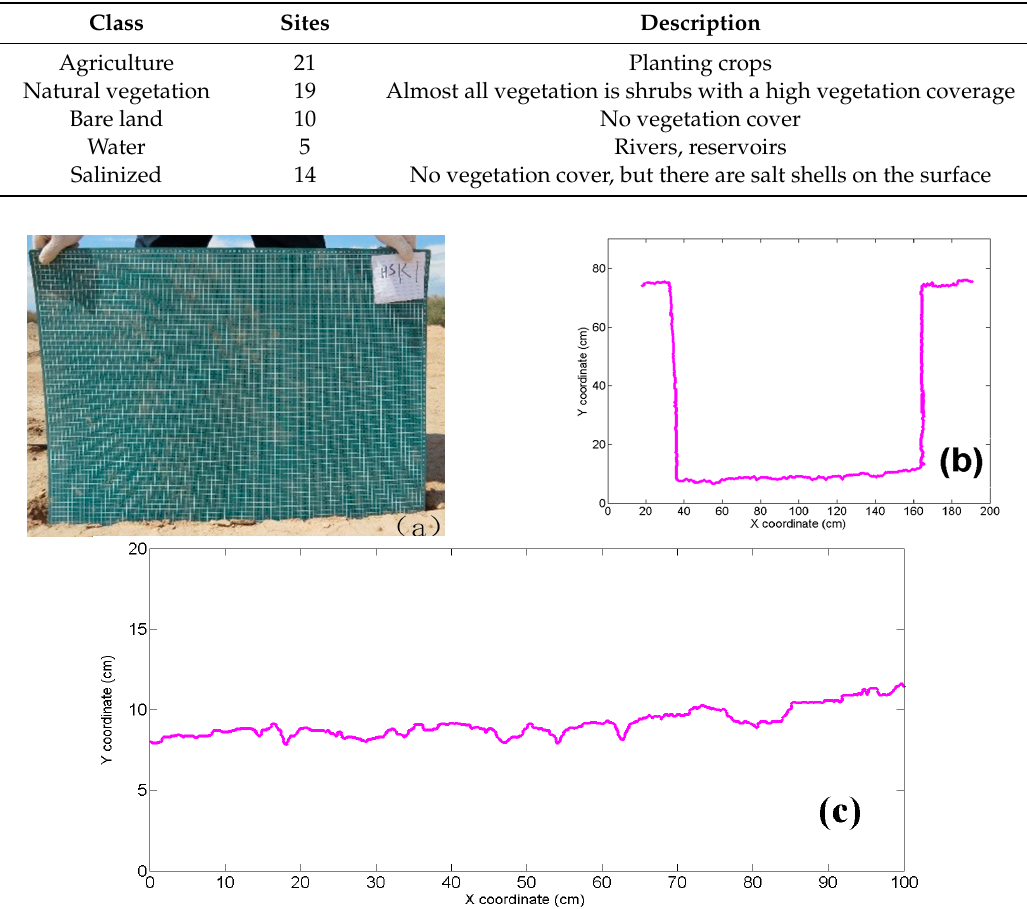
Figure 3. Soil roughness data processing: ( a ) sketch of roughness measurement; ( b ) image vectorization; ( c ) manual correction